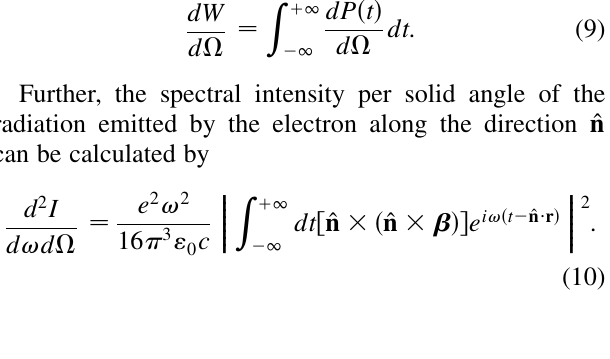
(cid:4) , (cid:7) 800 nm 0 ¼ 4